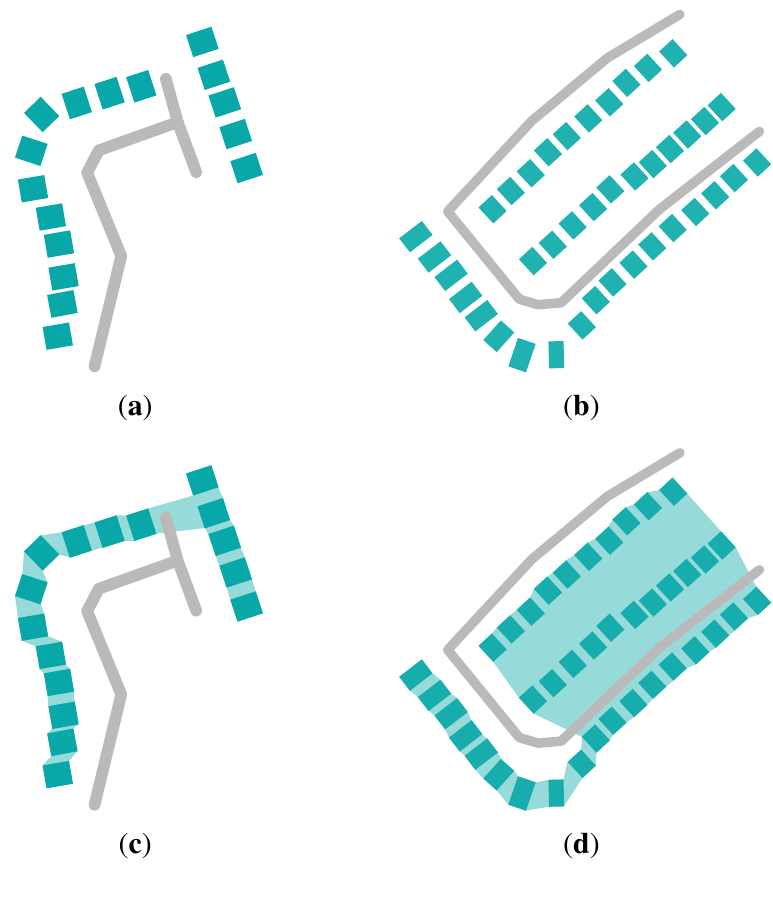
Figure 8. The results of merging the polygons in ( a ) and ( b ) are displayed in ( c ) and ( d )